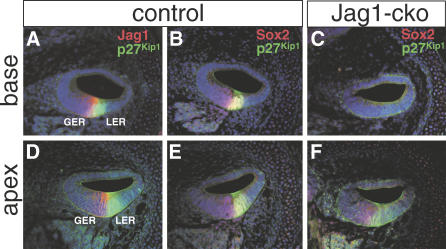
At E14.5 JAG1 Is Expressed Directly adjacent to the Prosensory Domain That Is Disrupted in Jag1-cko Inner EarsImmunocytochemistry at E14.5 using two markers of the prosensory domain, Sox2 and p27Kip1, in combination with JAG1 in both the basal and apical turns of the cochlea. Note that the JAG1 domain (red) does not overlap the p27Kip1 domain (green) (A and D), whereas the SOX2 domain does largely overlap with p27Kip1 (yellow) (B and E). Both SOX2 and p27Kip1 are down-regulated in the Jag1-cko cochlea (C and F), although there is weak expression of both markers in the apex (F). GER, greater epithelial ridge; LER, lesser epithelial ridge.